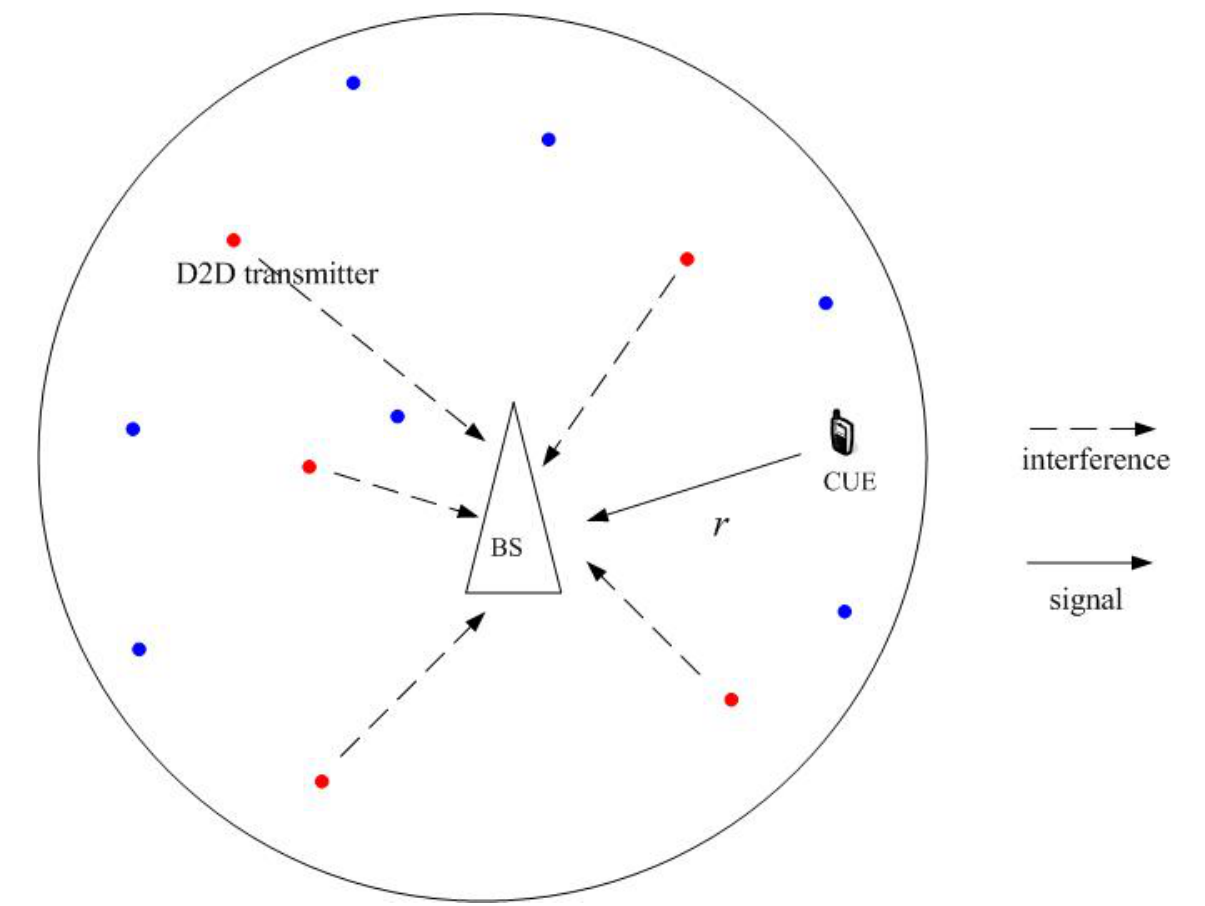
Figure 1. System model (Red dots denote D2D transmitters who share the frequency band with the CUE at time slot l . Blue dots denote members of Ψ \ Ψ 1 . D2D receivers are omitted in the